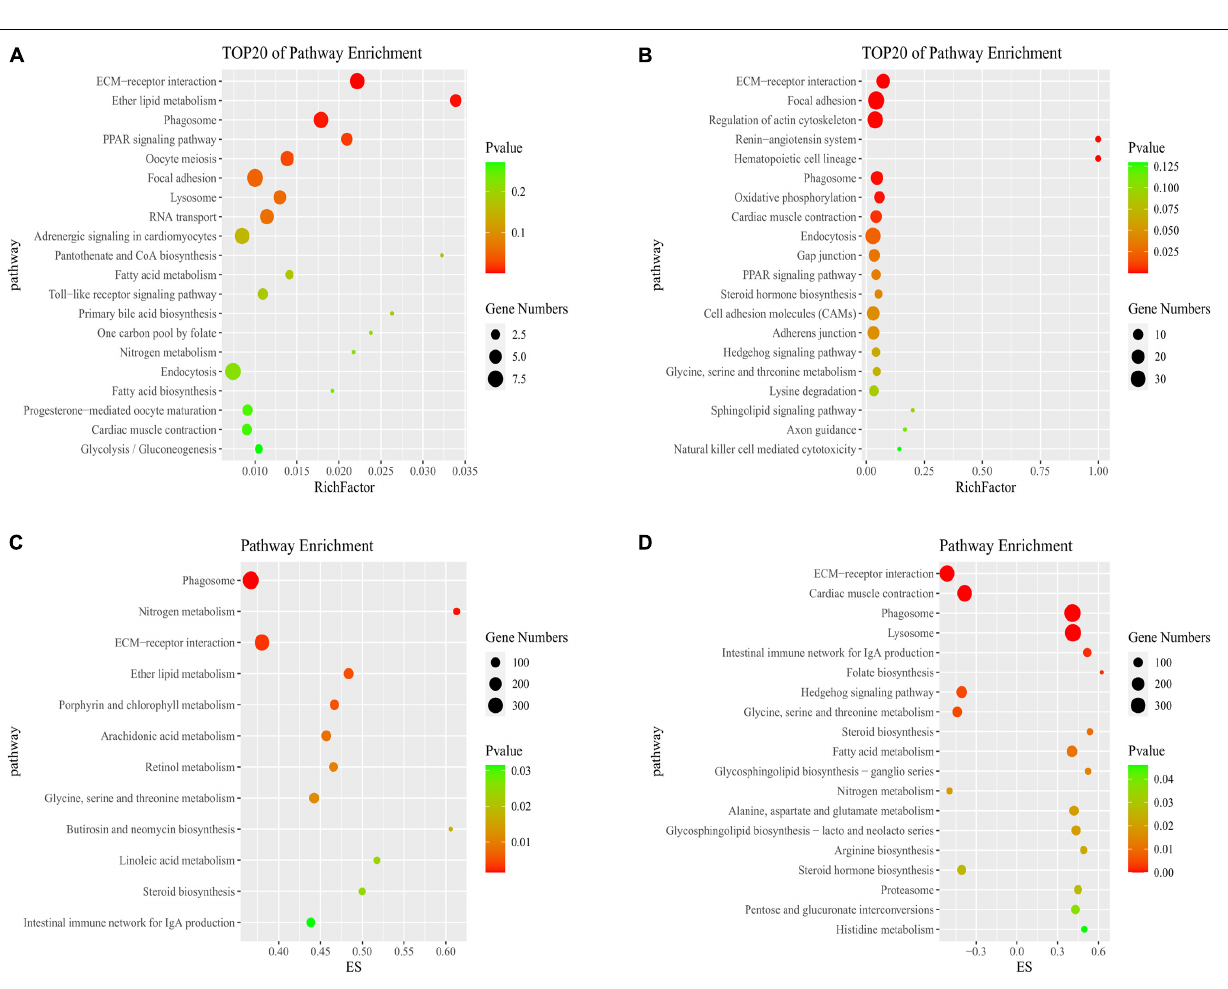
Frontiers in Genetics |